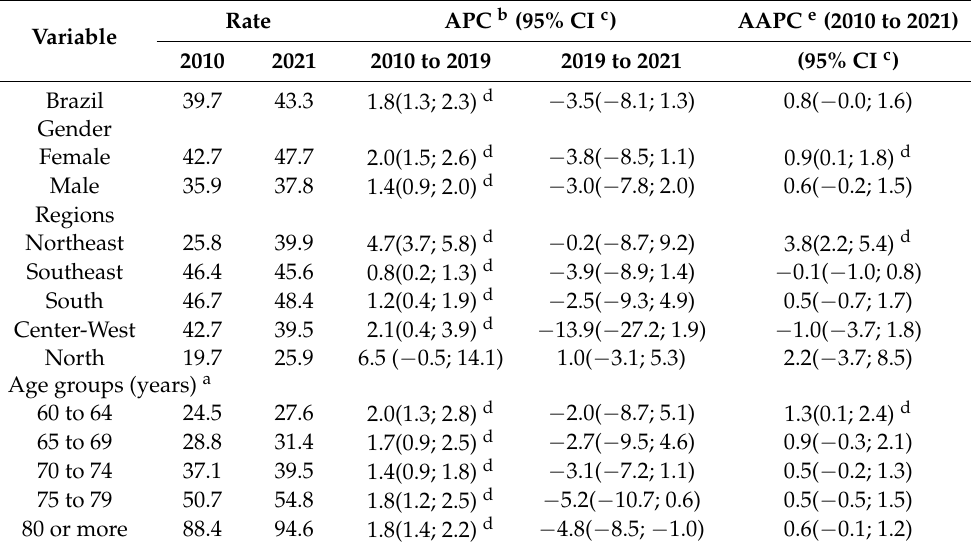
Table 1. Percentage change in the age-adjusted and gross fall-related hospitalization rate in elderly people (per 10,000 people). Overall data for Brazil and disaggregated data by gender, age groups, and region, 2010 to